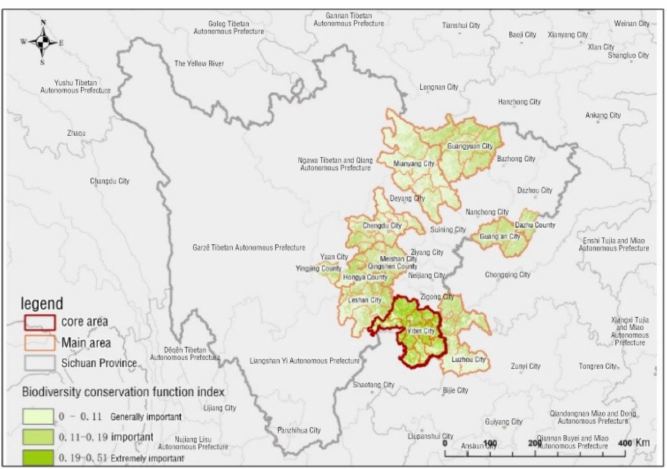
Figure 11. Biodiversity conservation functionality analysis of research areas in Sichuan Province.